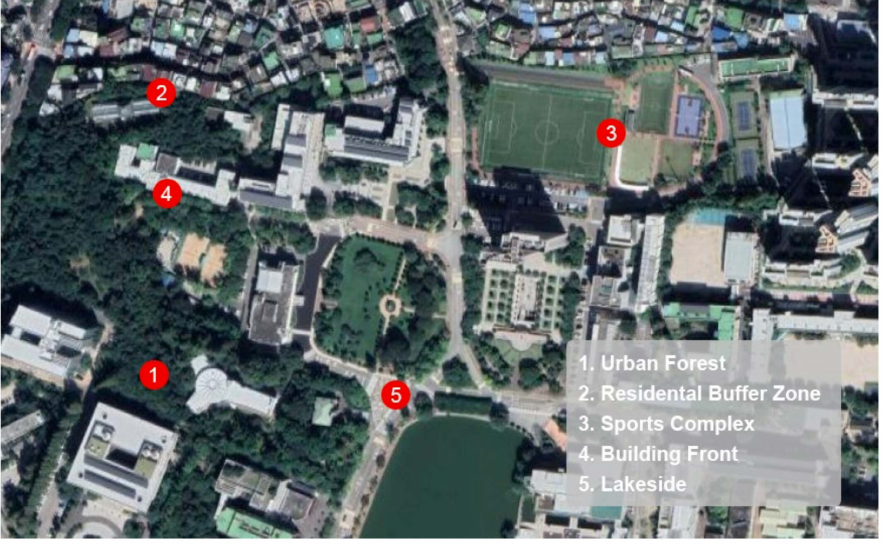
Figure 5. Real-time PM measuring